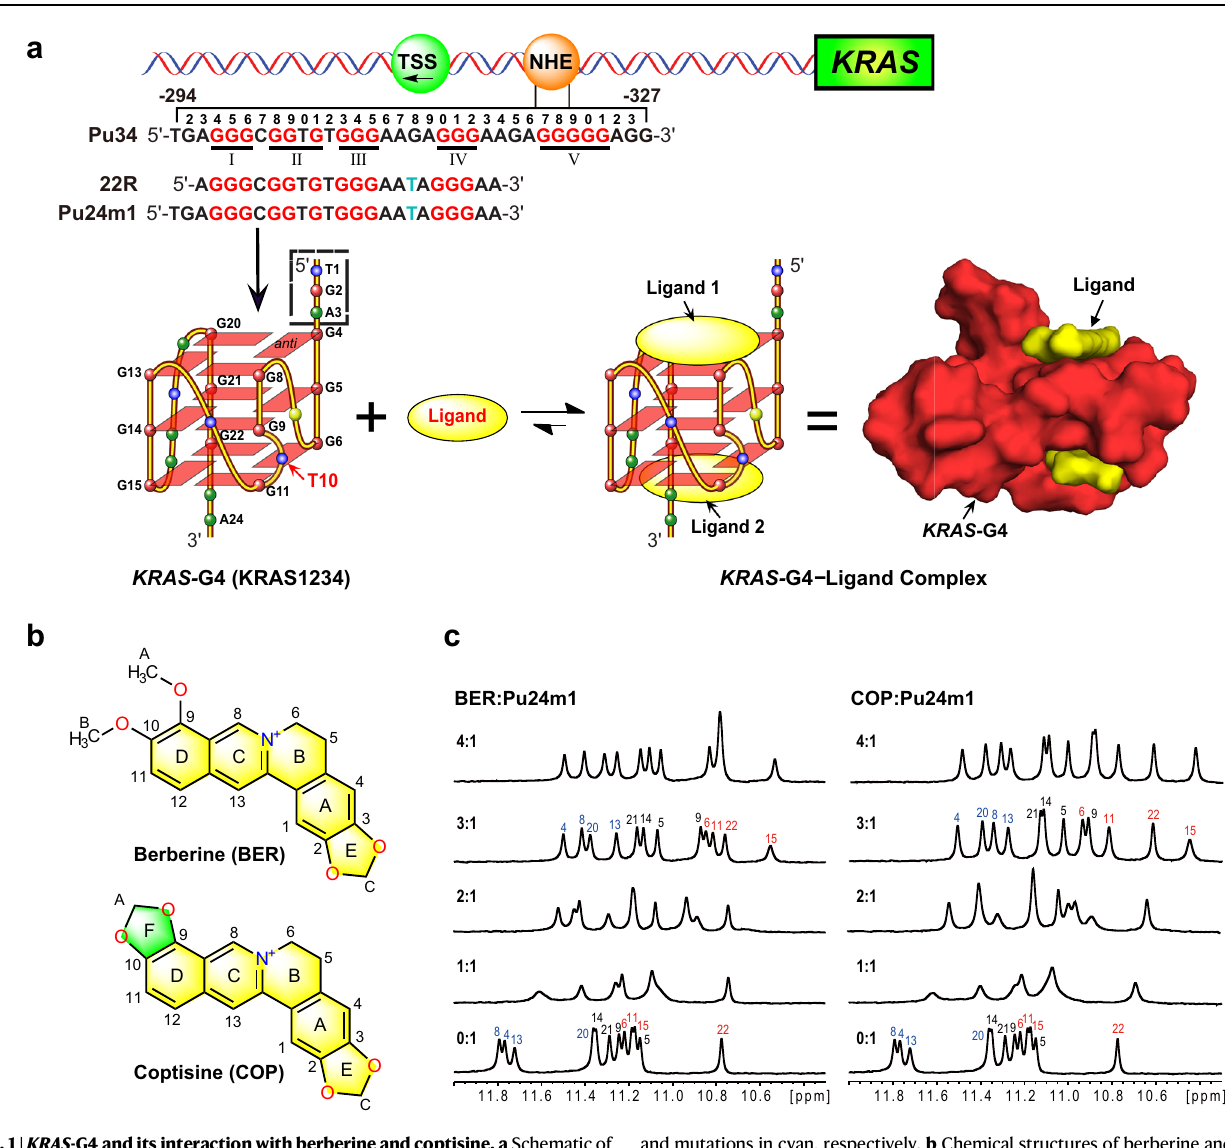
and mutations in cyan, respectively. b Chemical structures of berberine and cop- tisine with numbering. c 1D 1 H NMR titration of Pu24m1 DNA with berberine and coptisine, respectively, with complete imino proton assignment. Conditions: 150 μ M DNA, pH 7, 50mMK + solution, 25°C, DMSO- d 6